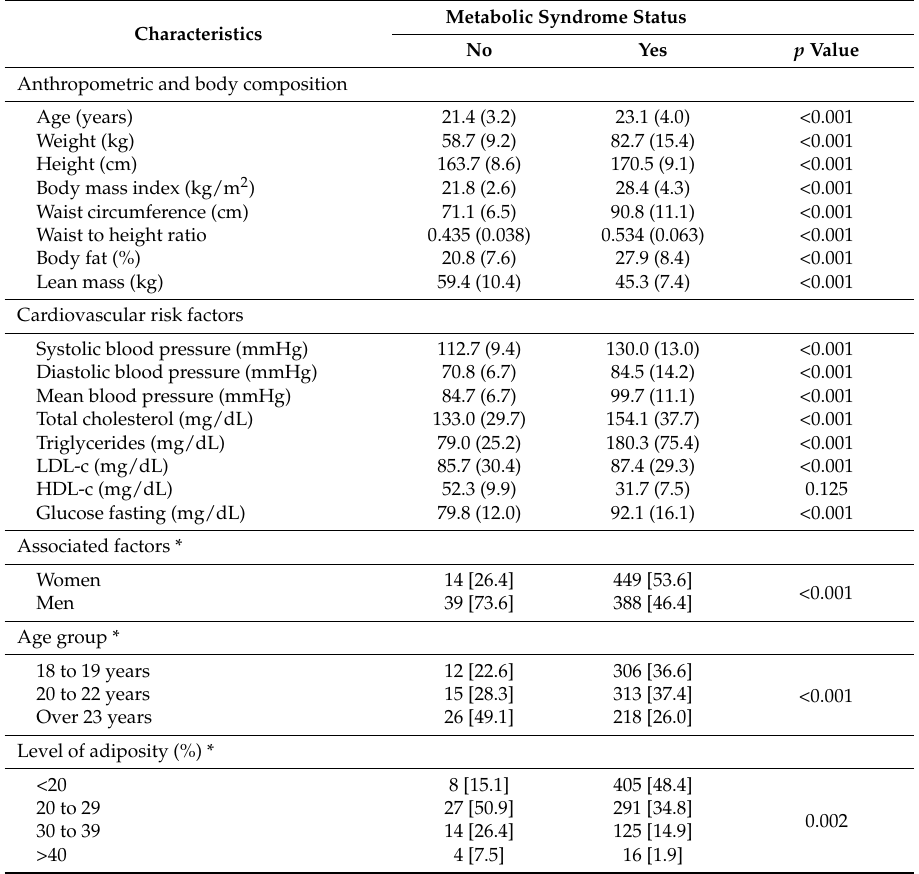
Table 2. Anthropometric, body composition, cardiovascular risk factors, and associated factors by metabolic syndrome